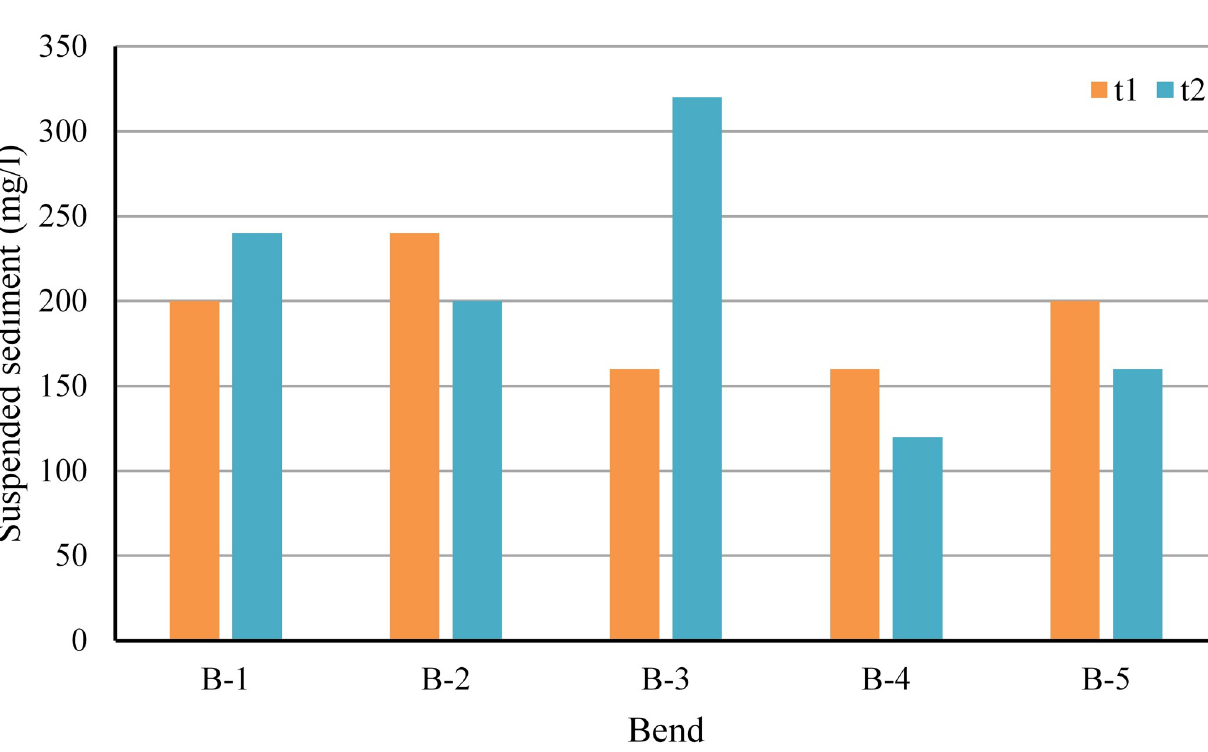
Fig 17. Suspended sediment concentrations in water at different bend